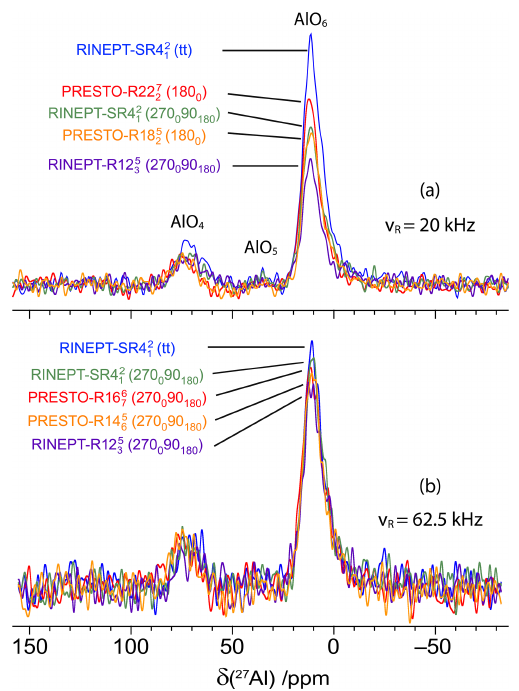
Figure 3. The 27 Al 1D spectra of γ -alumina at 18.8T with ν R = 20kHz (a) and 62.5kHz (b) acquired using 1 H → 27 Al transfers with RINEPT-CWc and SR4 2 R12 5 (270 0 90 180 ), or PRESTO and (a) R22 7 3 or (b) R16 6 (270 0 90 180 ) and R14 5 7